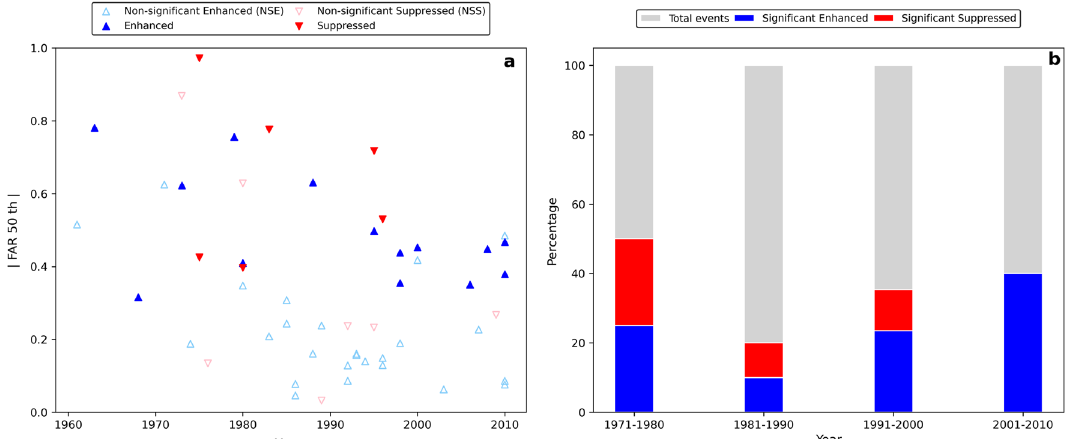
Figure 2. ( a ) Scatterplots of fraction of attribution risk (FAR, absolute values) and flood year and ( b ) bar chart of enhancement or suppression of flooding events during 1961–2010. Detailed information on these flood events is provided in Supplementary Table